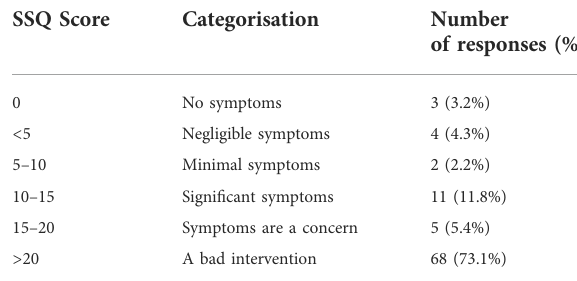
TABLE 3 Participant responses and categorisation — SSQ total